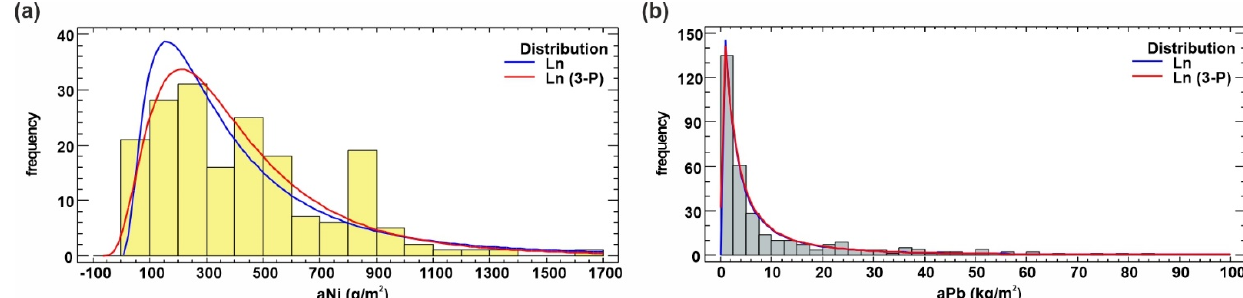
Figure 12. Histograms and theoretical distributions (lognormal (Ln) and lognormal three-parameter (Ln 3-P)) of the abundances of Ni (( a ): aNi) and Pb (( b ): aPb) for sets used to validate the prediction quality (combined training and testing datasets) (Figure 11).